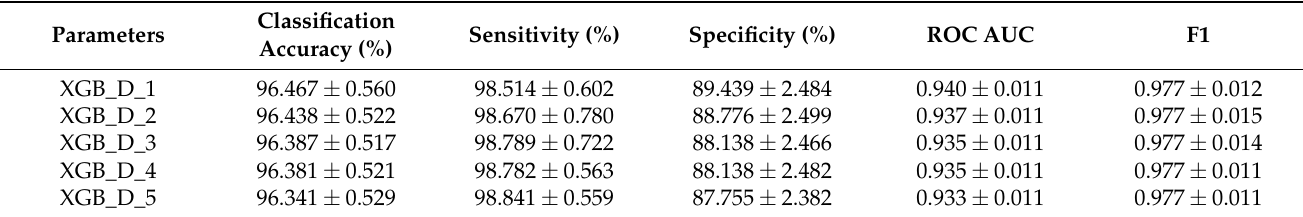
Table 9. Best results for the XGBoost algorithm (dynamic